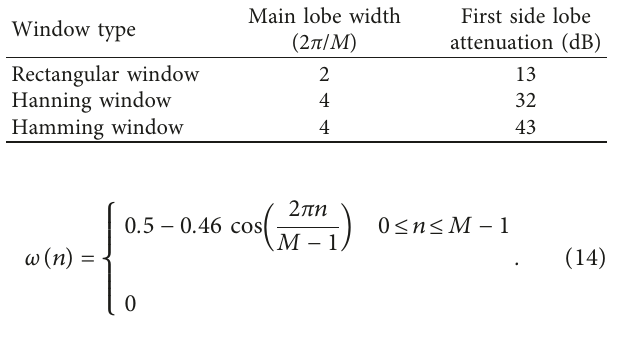
Table 2: Performance comparison of three window functions.